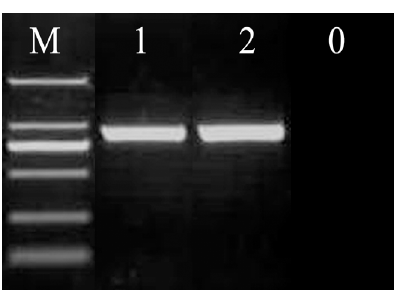
Fig. 1. Typical PCR for identification of the S. nitidum ; M: Marker (DL 2000); 1: Snit1; 0: Blank